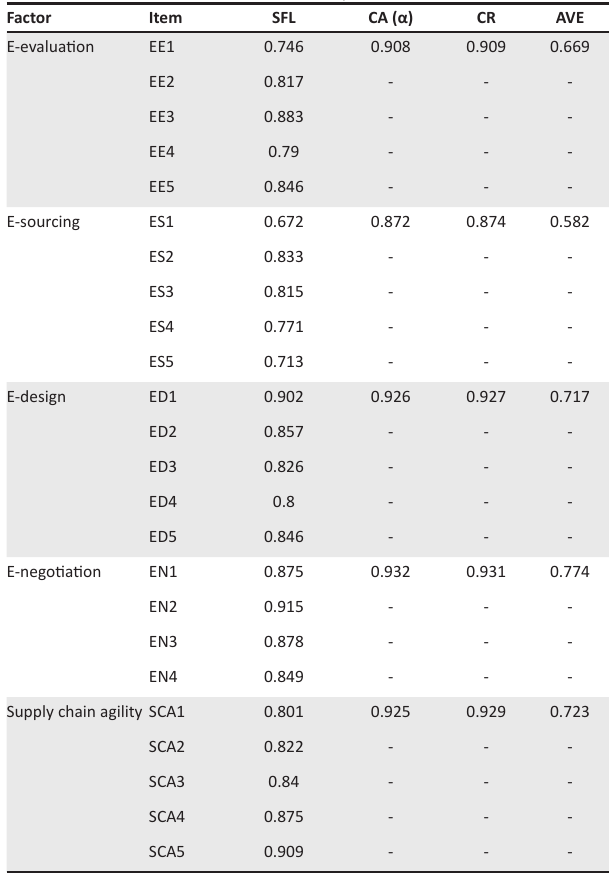
TABLE 3: Measurement model statistical